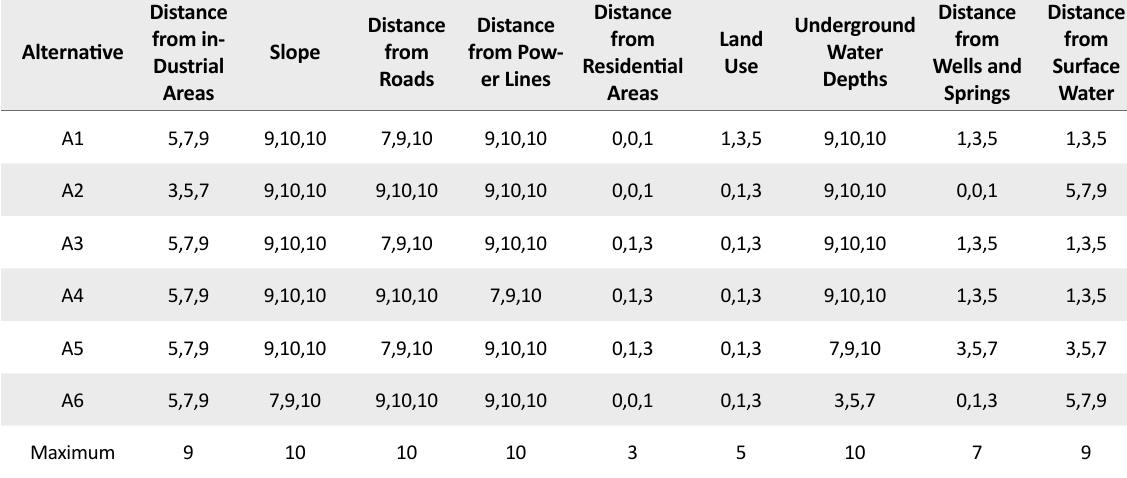
Table 7. Decision matrix in fuzzy TOPSIS method